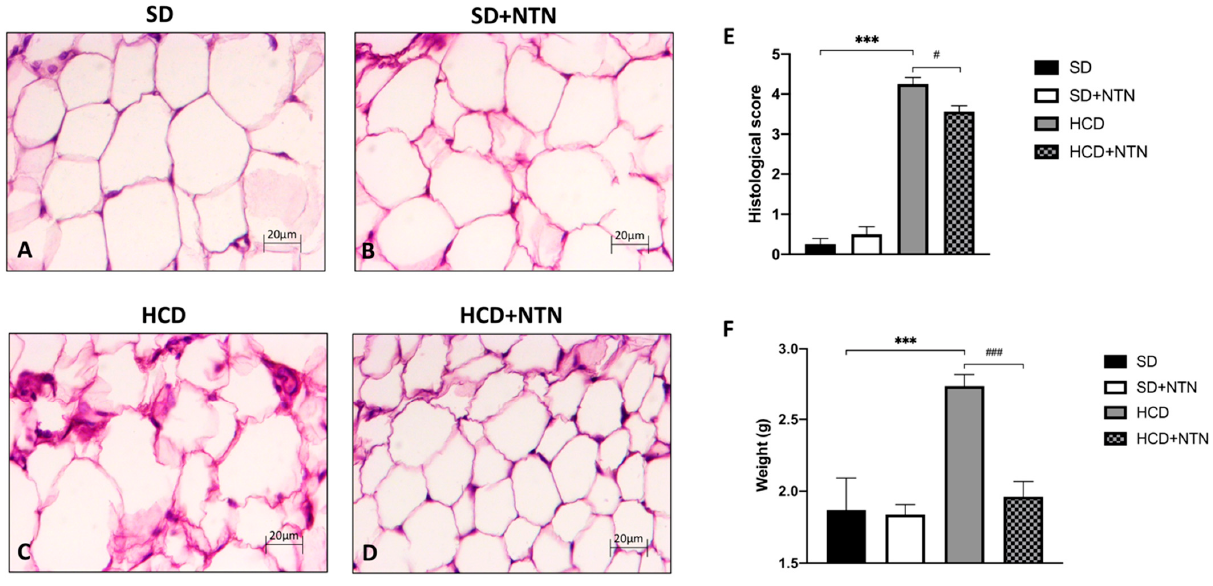
Figure 3. Effect of NTN on adipose abdominal tissue and liver in HCD mice. HCD mice showed a significant tissue injury in adipose tissue ( C , E ); to the contrary, SD and SD + NTN mice showed no tissue damage ( A , B , E ). NTN restored physiological parameters, thus reducing neutrophil infiltration and adipocytes size ( D , E ). In addition, NTN was able to decrease liver weight ( F ). Data are representative of at least three independent experiments. Values are means ± SEM. One-Way ANOVA test. *** p < 0.001 vs. SD; # p < 0.05 vs. HCD; ### p < 0.001 vs. HCD.